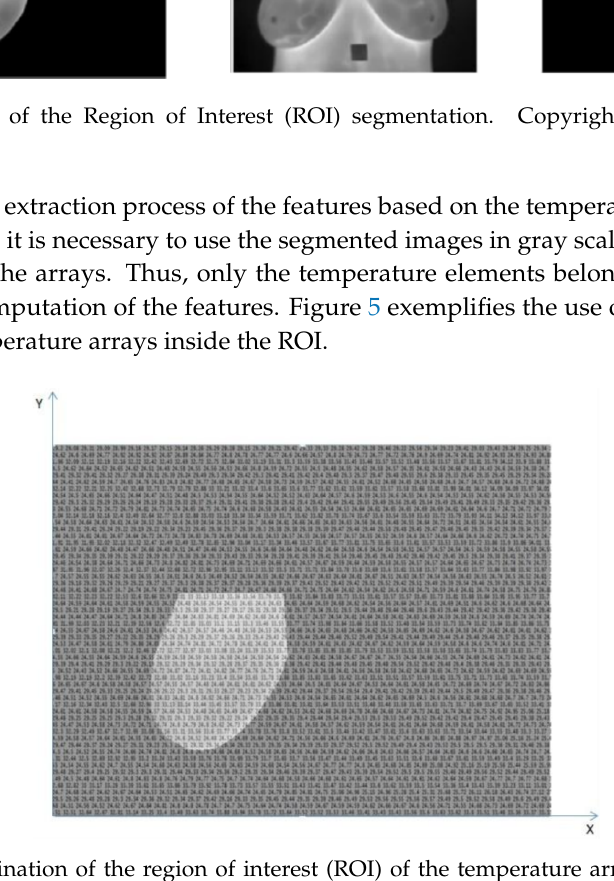
Figure 5. Determination of the region of interest (ROI) of the temperature array from the ROI in gray